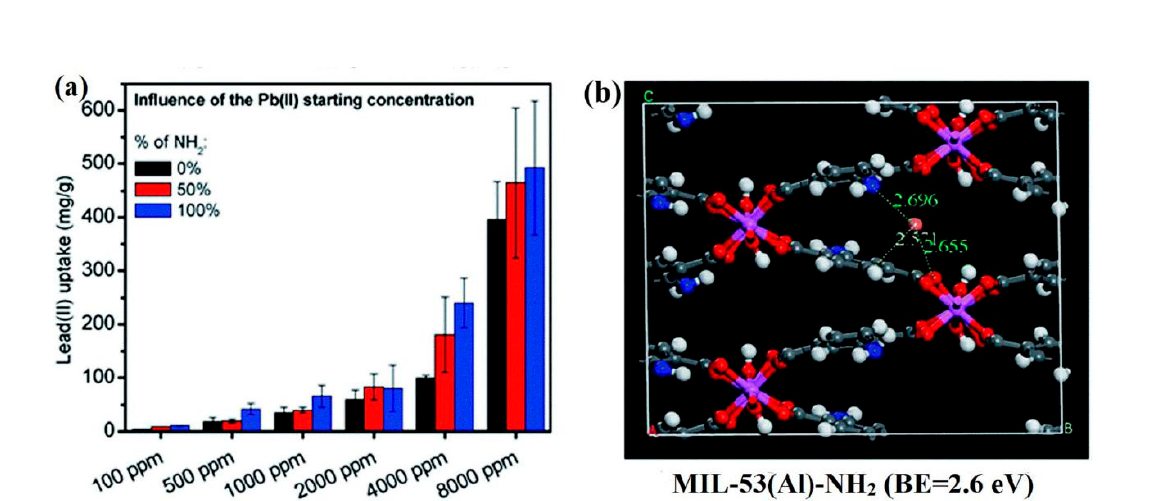
Figure 4. ( a ) Lead(II) uptake in water by magnetic framework composites (MFCs) with different loadings of amino groups, using different initial concentrations of Pb(II) (100 to 8000 ppm); ( b ) the density functional theory (DFT) ‐ optimized locations and binding energies of the lead atom in MIL–53(Al)–NH 2 calculated using the DFT ‐ D2 method; The distances shown are in angstroms. Color code: C, grey; H, white; N, blue; Al, pink; Pb, orange. Reproduced with permission from [77]. Copyright Royal Society of Chemistry, 2015.